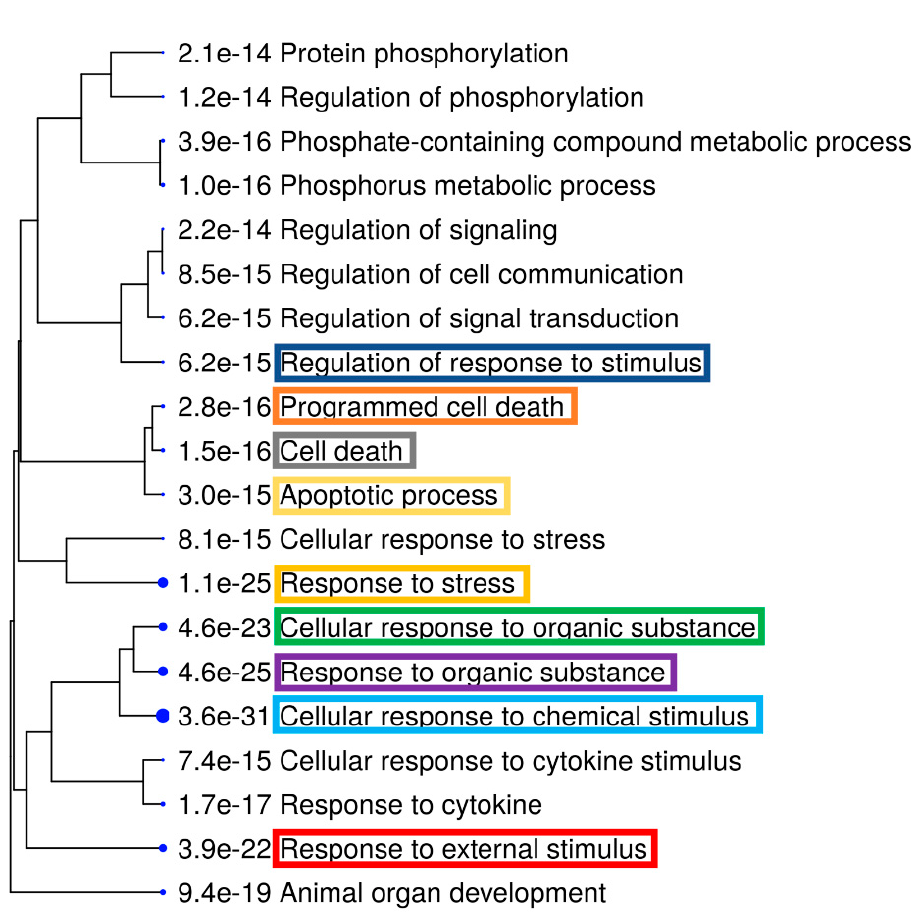
Figure 6. Enriched biological processes after treatment of hTCEpi cells with AC EFs for 24 h. Significantly enriched biological processes following analysis of the gene array data are highlighted as an interactive hierarchical clustering tree using ShinyGO. Biological processes with many shared genes are clustered together. Bigger dots indicate more significant p -values. Enriched biological processes that were similar after analysis of both gene and proteins array data are marked and highlighted. Analysis was performed using ShinyGO (v.0.61) (Available online: http://bioinformatics.sdstate.edu/go/ (accessed on 6 January 2021)).